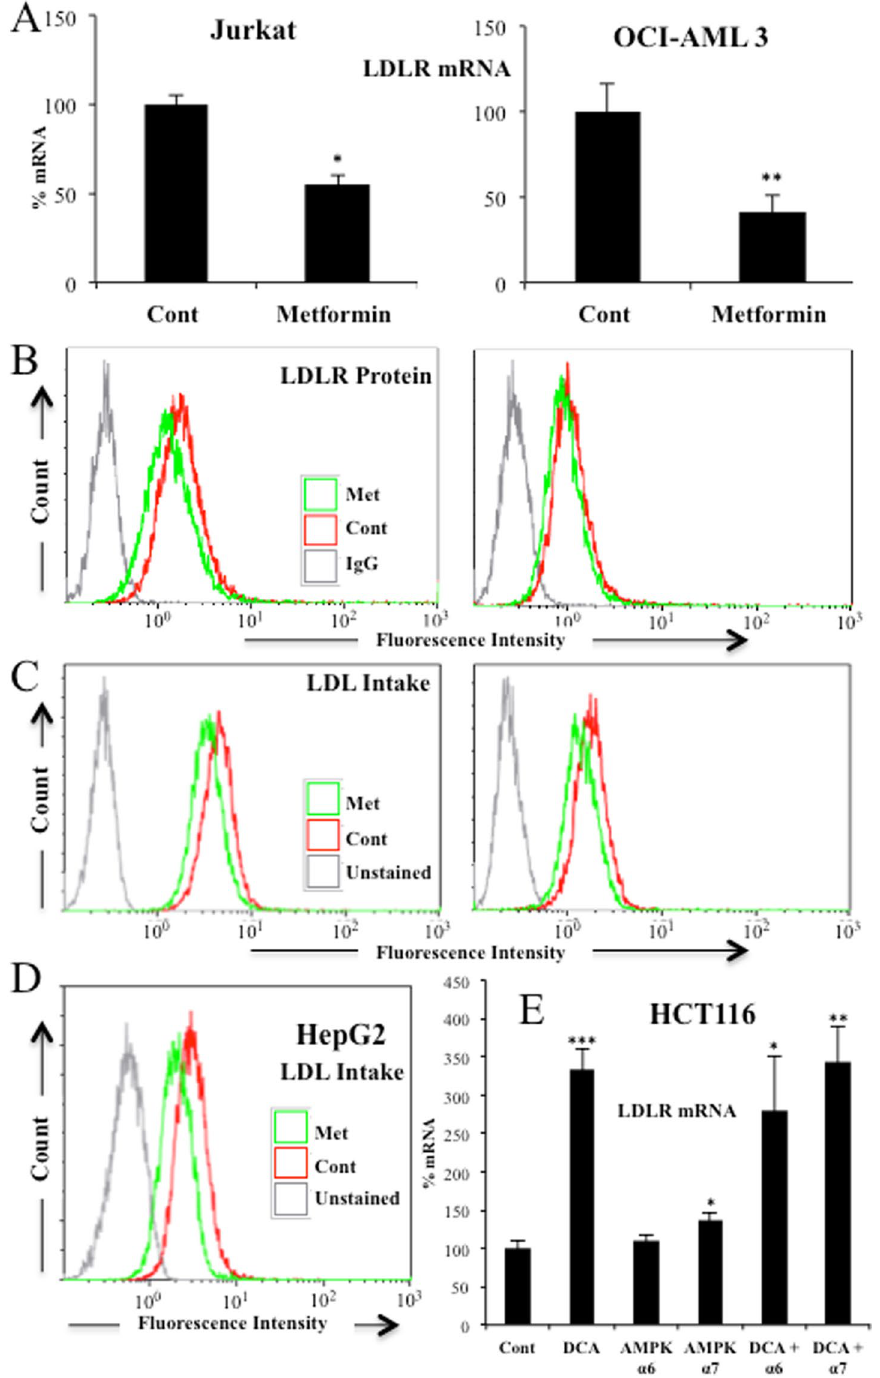
Figure 6. AMPK did not regulate DCA-induced LDLR expression and LDL uptake. Two different hematopoietic cell lines were treated with 5 mM metformin for 24 h and LDLR mRNA ( A ), protein ( B ) and LDL uptake ( C ) were analyzed. ( D ) HepG2-C3A cells were treated as in ( A ) and LDL uptake was measured. ( E ) HCT116 cells were transfected with 2 small interference RNA (siRNA) for AMPK α or with control siRNA and treated with 20 mM DCA for 6 h before mRNA